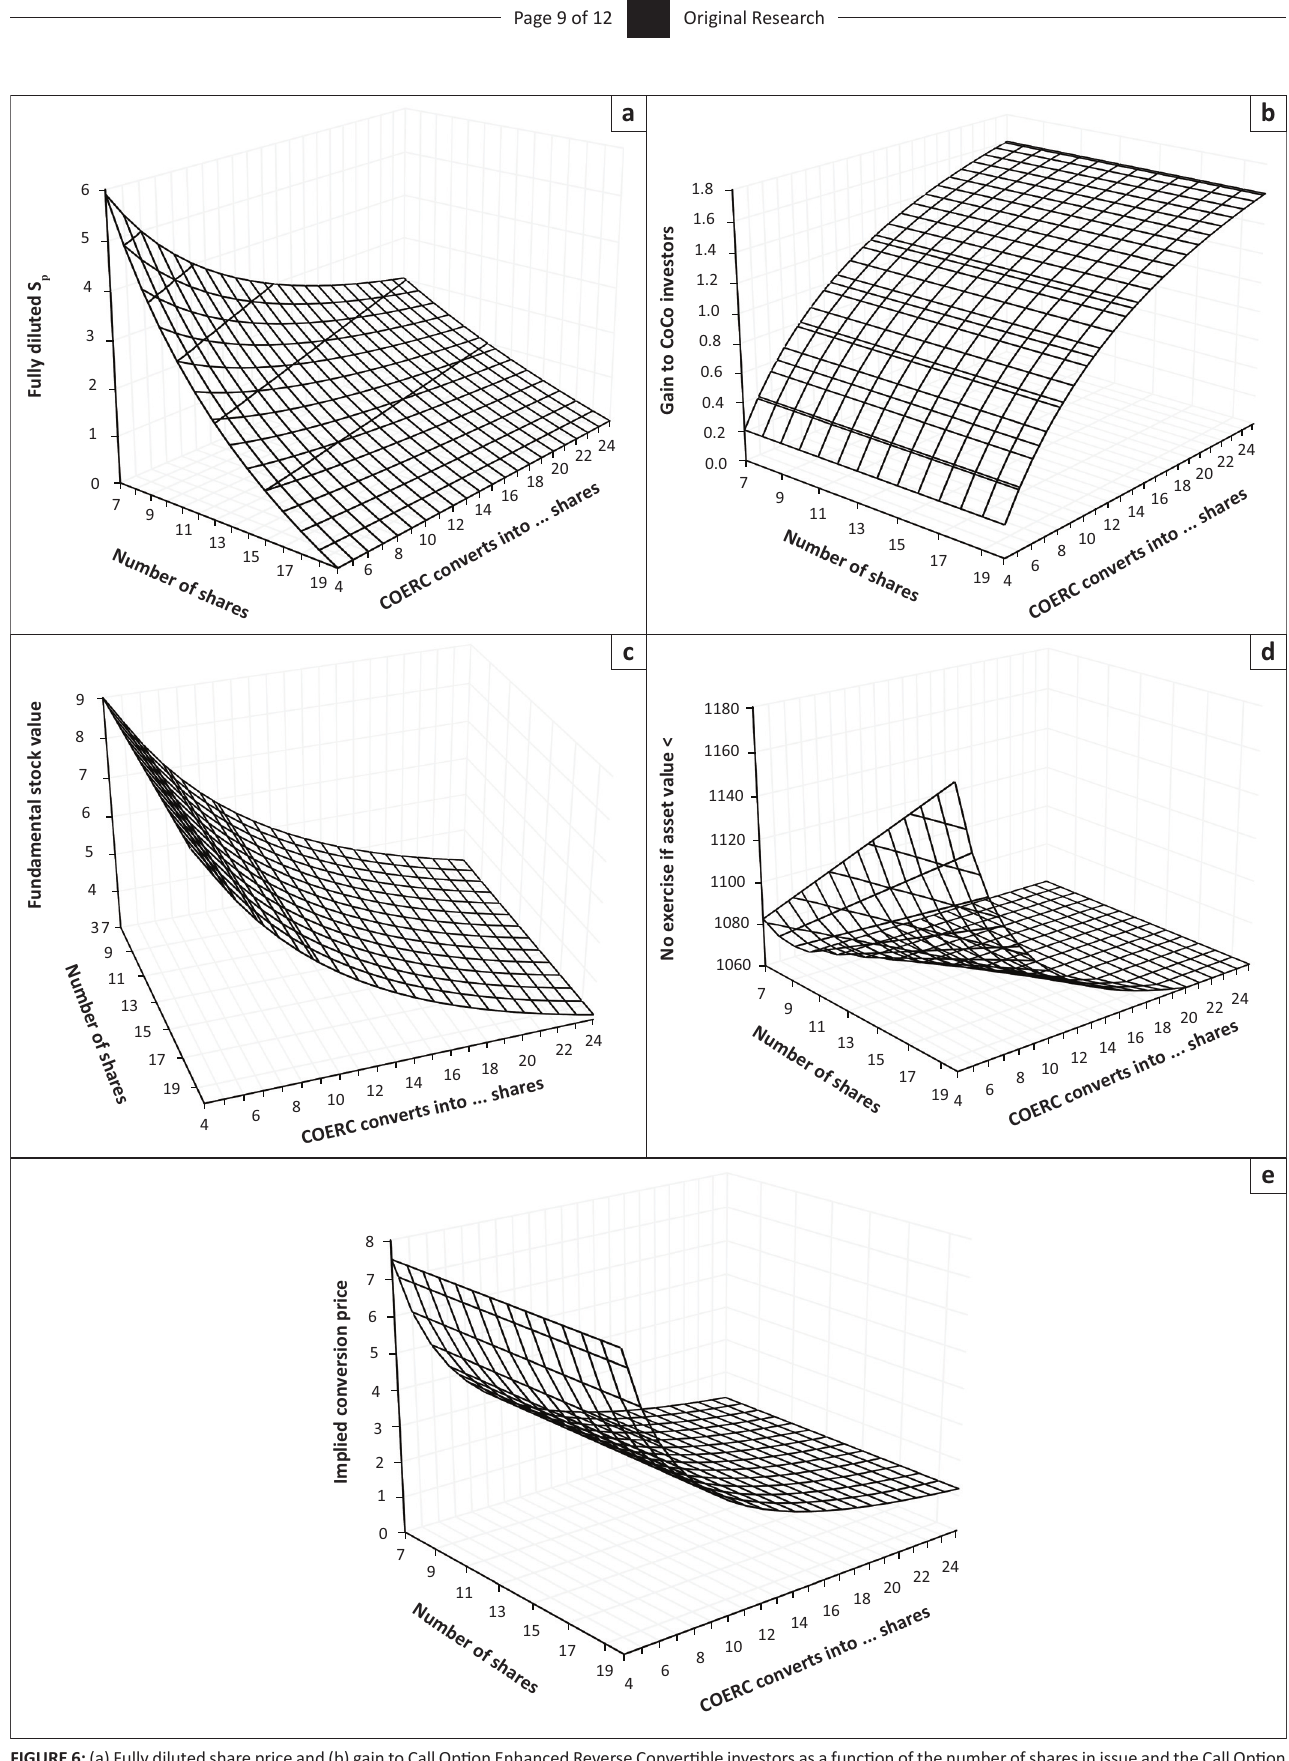
FIGURE 6: (a) Fully diluted share price and (b) gain to Call Option Enhanced Reverse Convertible investors as a function of the number of shares in issue and the Call Option Enhanced Reverse Convertible conversion rate, (c) fundamental stock value and (d) option exercise threshold as a function of the number of shares in issue and the Call Option Enhanced Reverse Convertible conversion rate, (e) implied conversion price, c , as a function of the number of shares in issue and the Call Option Enhanced p Reverse Convertible conversion